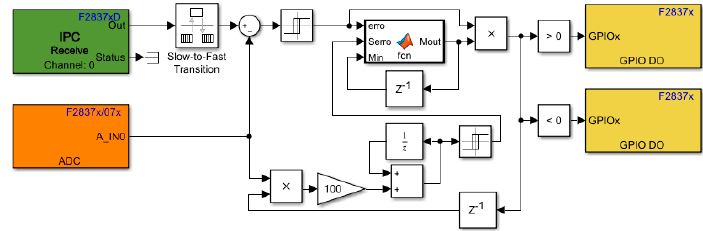
Figure 8. TI DSP Core 1 digital control block diagram for the u C